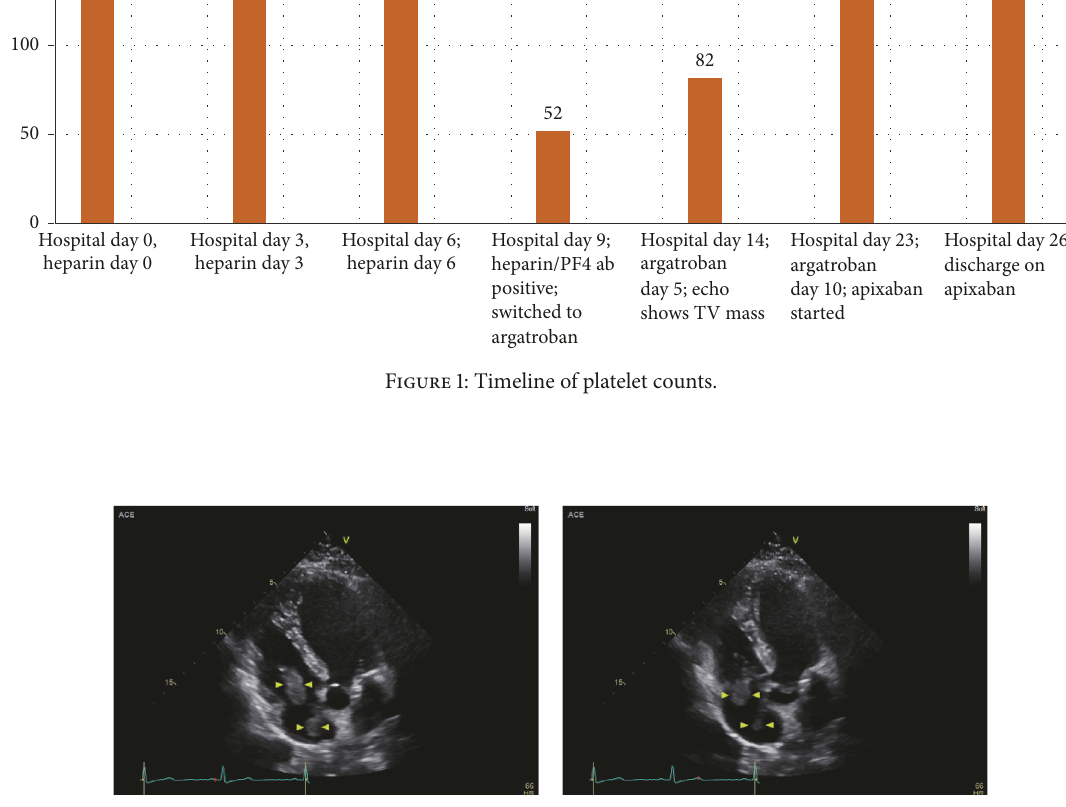
Figure 2: TTE showing the mobile right atrial mass that was traversing the tricuspid